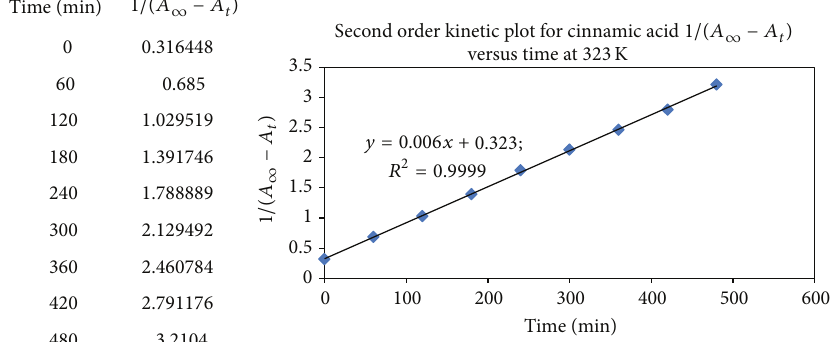
Figure 3: Second order kinetic plots of cinnamic acid 1/𝐴 𝑡 versus time at 323 K. [CA] = 6.25 × 10 −3 moldm −3 ; [Phen] = 6.25 × 10 −3 moldm −3 ; [Fe(III)] = 1.25 × 10 −3 moldm −3 ; [PEG-200] = 9.37 × 10 −1 moldm −3 .